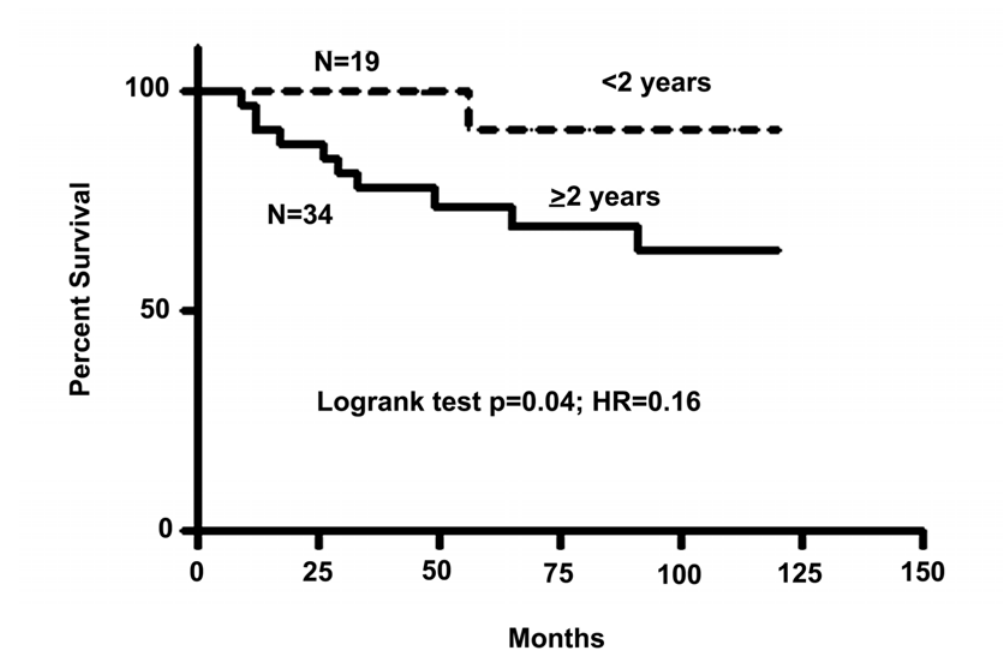
Figure 2 – Influence of age in disease-free survival rates.